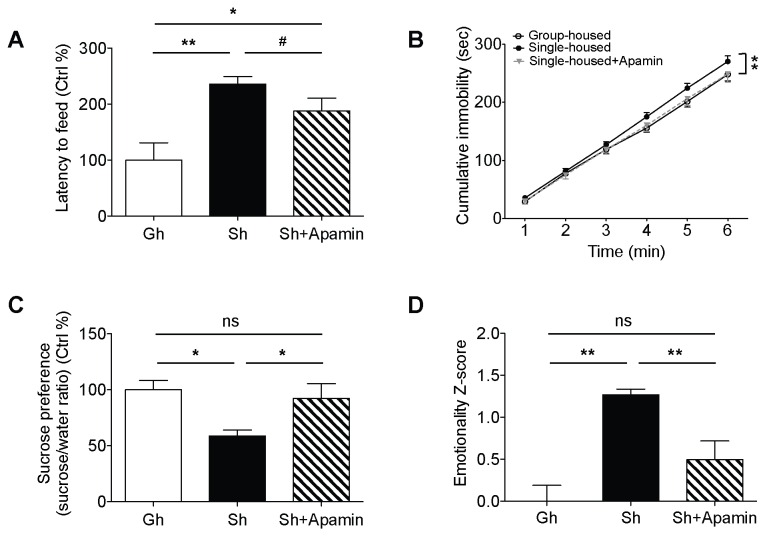
Decreased anxiety/depression-like behaviors in single-housed mice after systemic apamin.(A) Single-housed mice showed increased latency to feed, which was only partially recovered upon apamin treatment in the novelty suppressed feeding test (one-way ANOVA, group effect, p=0.001, Newman-Keuls posthoc test, *p<0.05, **p<0.01; a priori t-test between Sh and Sh+Apamin, #p=0.09). (B) Single-housed mice showed increased immobility in the tail suspension test suggesting enhanced depressive-like behavior, normalized by apamin treatment (two-way ANOVA, main effect of group, p=0.01, Newman-Keuls posthoc test, **p<0.01). (C) Single-housed mice showed decreased sucrose preference, which was restored by apamin treatment (one-way ANOVA, main effect of group, p=0.02, Newman-Keuls posthoc test, *p<0.05). (D) Single-housed mice showed overall increased emotionality, which was decreased by apamin treatment (one-way ANOVA, main effect of group, p<0.01, Newman-Keuls posthoc test, **p<0.01). Data are represented as mean ± S.E.M. (n = 7–9 per group). Gh; group-housed, Sh; single-housed, ns; not significant.